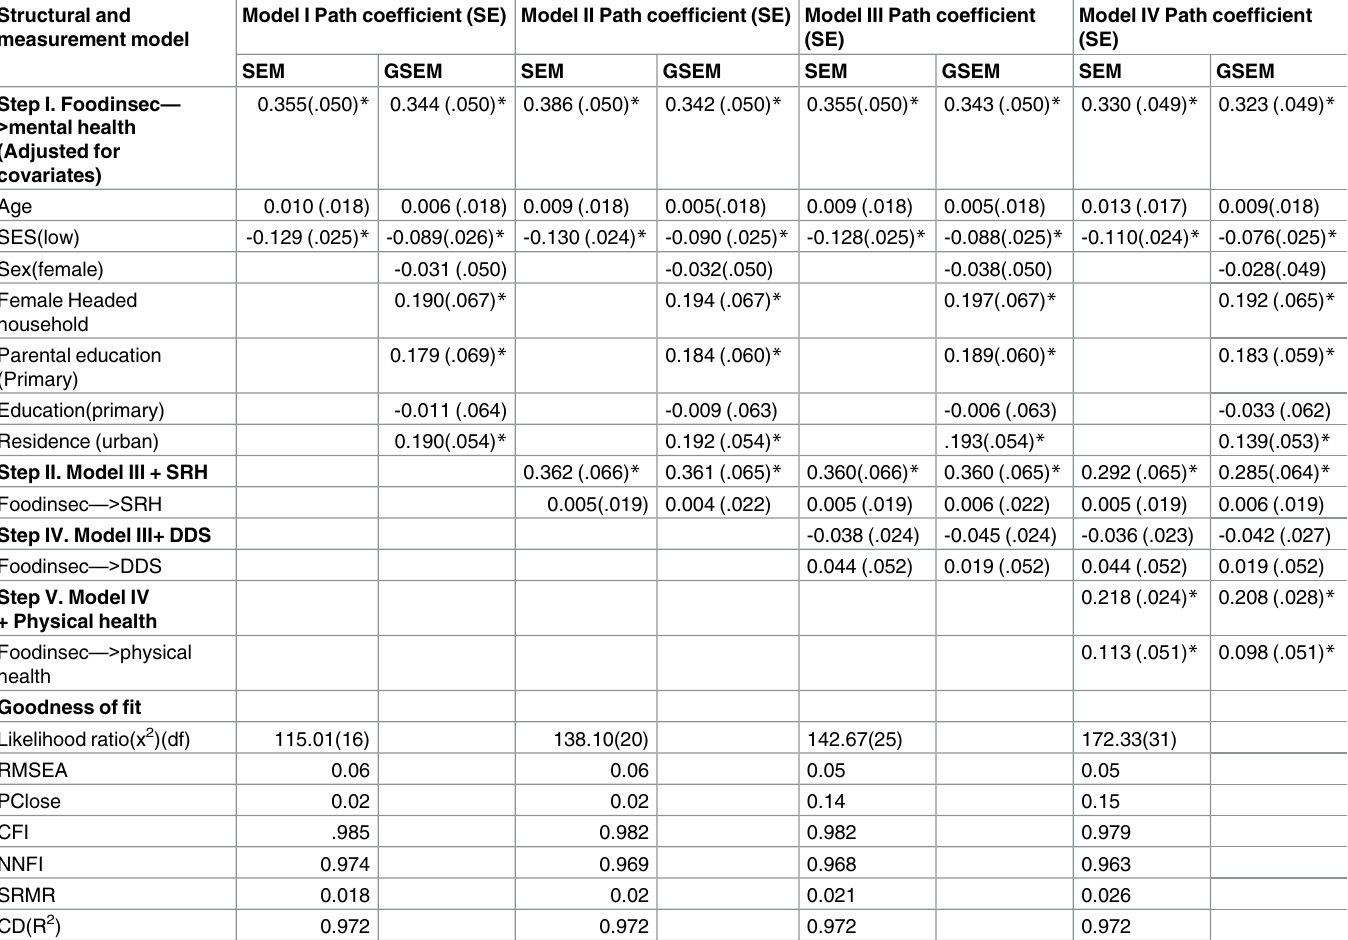
Table 3. Unstandardized Path coefficient estimatesof food insecurity on youth common mental disorders, JLFSY, Southwest Ethiopia,2015. Structural and measurement